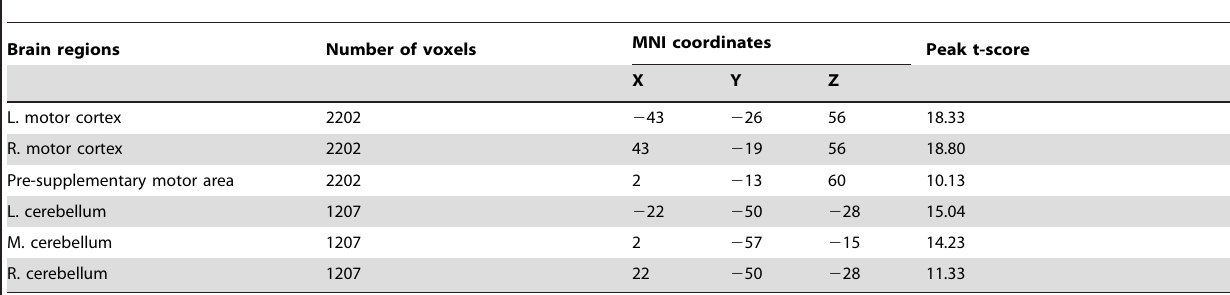
Table 1. Whole-brain searchlight analysis of motor representational distinctiveness, collapsing across age.